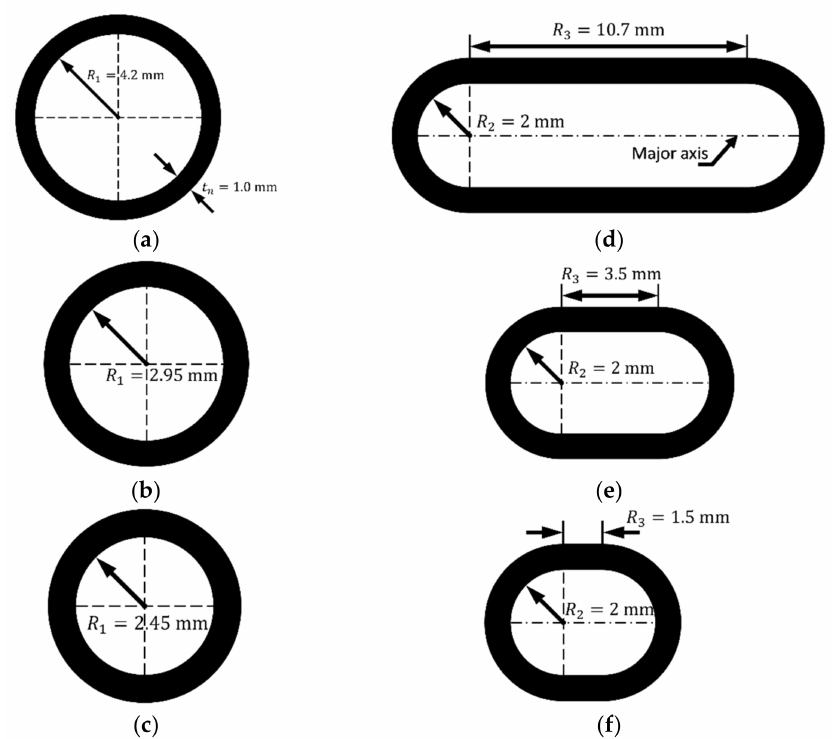
Figure 2. Inlet geometry of the sampling probe: ( a ) 5 m/s free-stream, circular inlet; ( b ) 10 m/s free-stream, circular inlet; ( c ) 15 m/s free-stream, circular inlet; ( d ) 5 m/s free-stream, ellipsoidal inlet; ( e ) 10 m/s free-stream, ellipsoidal inlet; and ( f ) 15 m/s free-stream, ellipsoidal